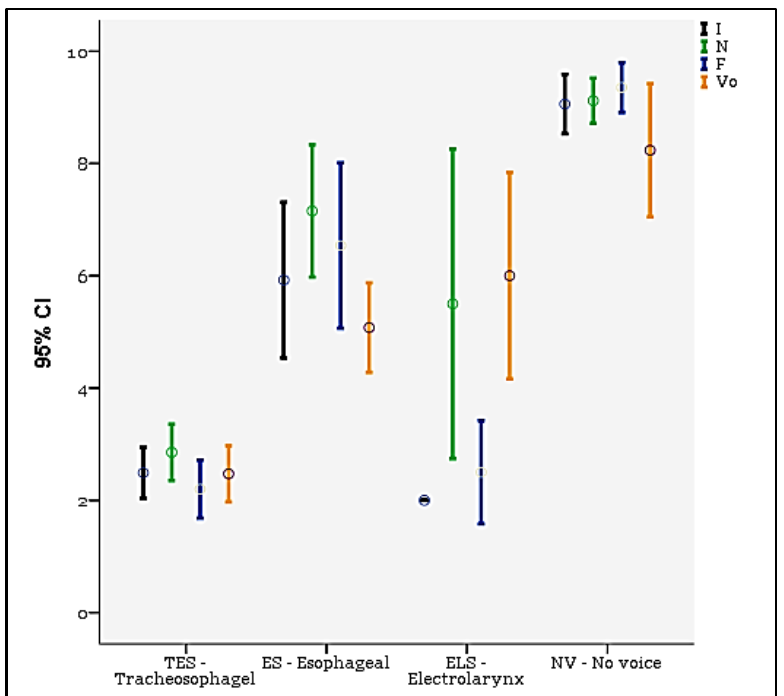
Figure 5. INFVo judgment of specialists on alaryngeal speech, circle represents the mean, bars represent 95% CIs. Legend: I, impression; N, noise; F, fluency; Vo, quality of voice. Score legend: 0 (very good substitution voice)–10 (very deviant substitution